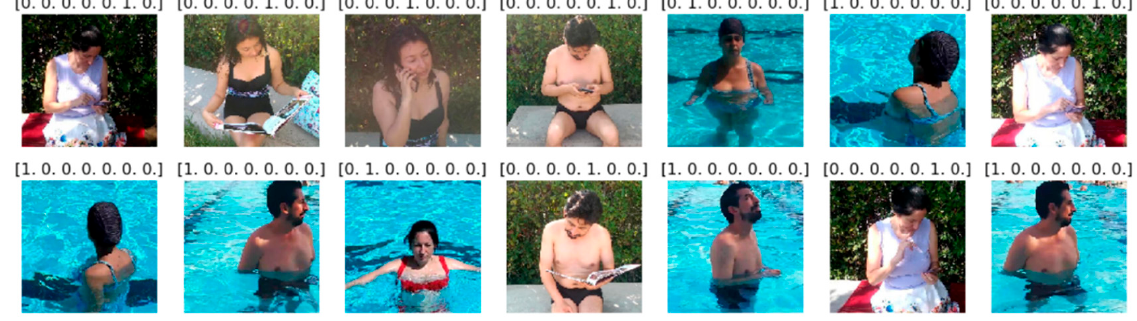
Figure 9. Image set of each category with their respective training labels.